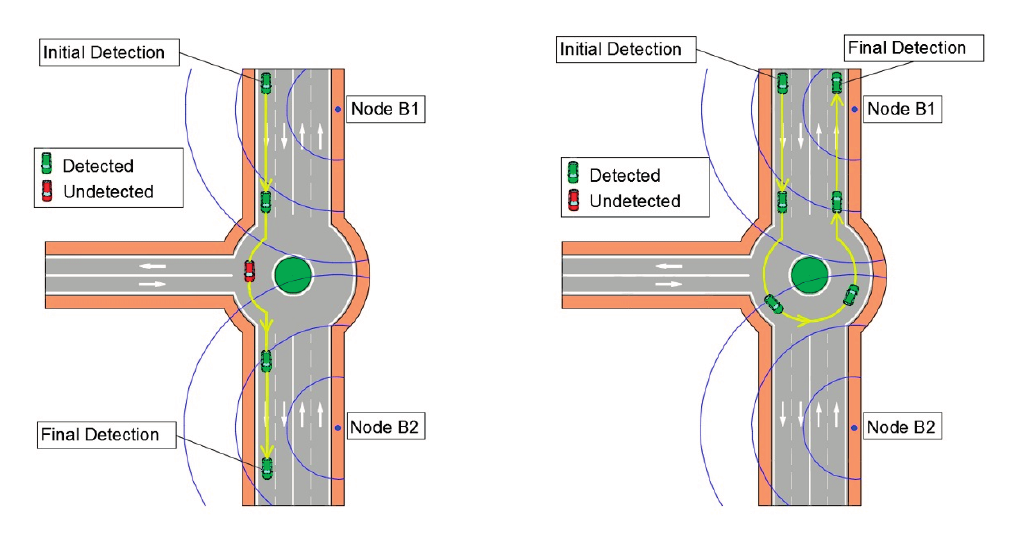
Figure 14. Vehicle detection using Bluetooth